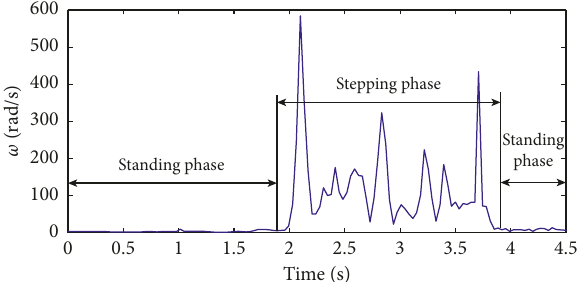
Figure 3: Angular velocity change during the walking